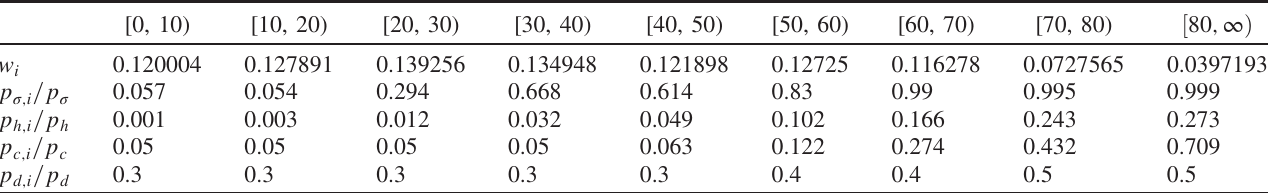
TABLE II. Table of age-specific parameters, including the age distribution w i and the various probabilities of transitioning between various states in our model. We present the unscaled distribution p x;i =p x , where p x denotes the overall scaling that is sampled during parameter inference (or whose value is otherwise set as described in the text).